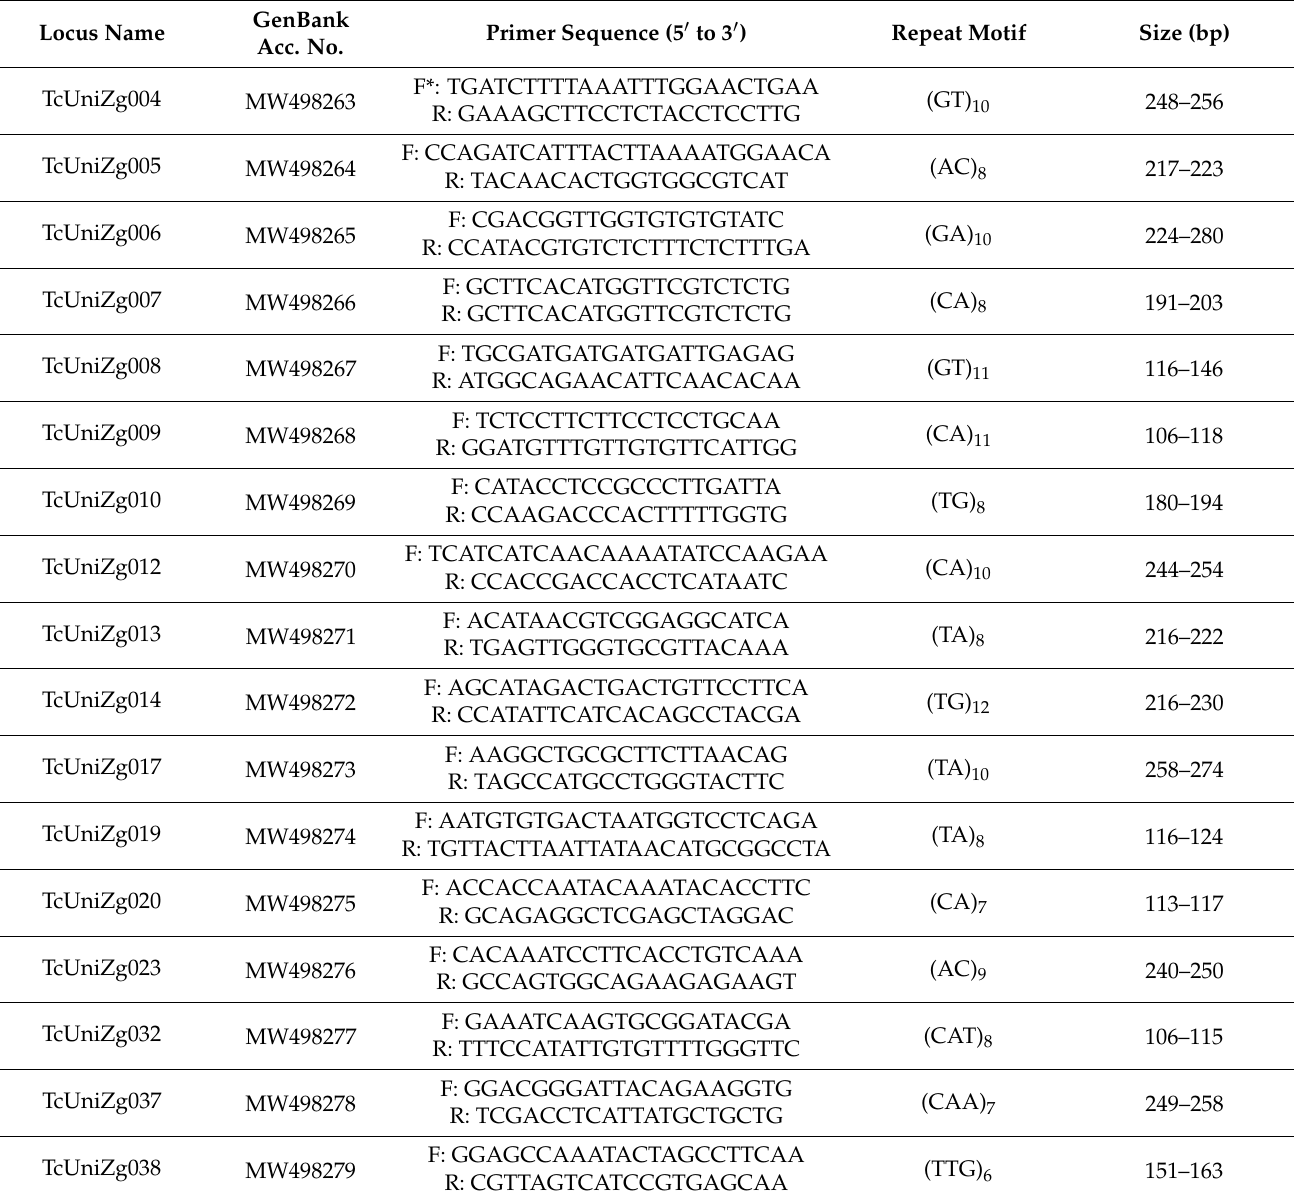
Table 2. List of 17 newly developed SSR markers for T. cinerariifolium